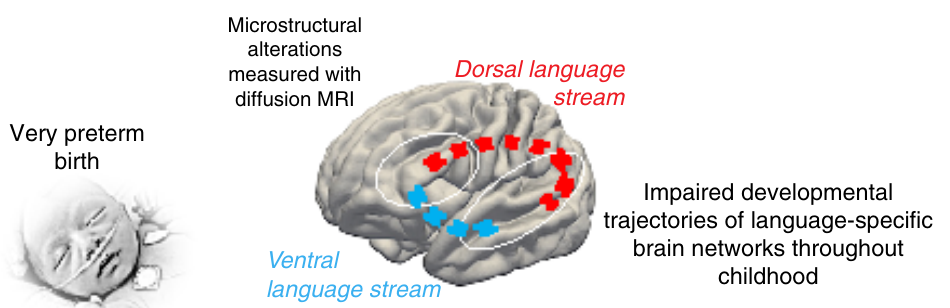
Figure 1. Altered developmental trajectories of language-specific brain networks following very preterm birth may lead to long- lasting language impairments. MRI, magnetic resonance